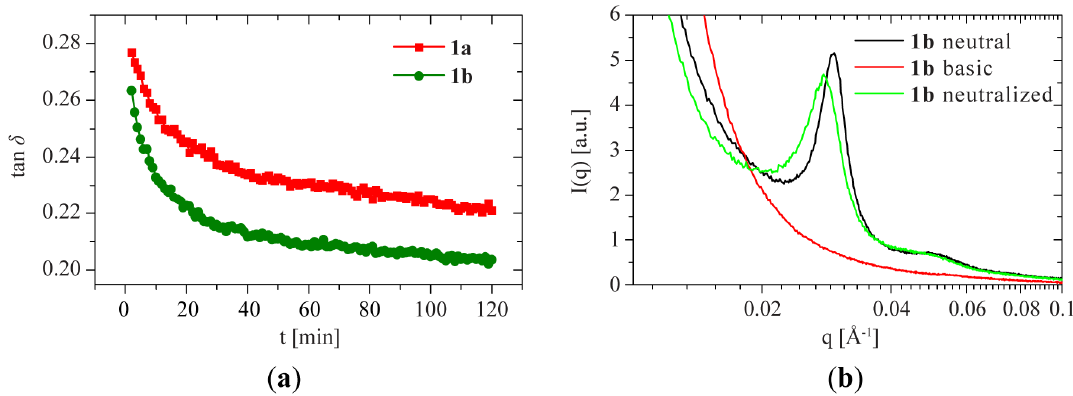
Figure 10. pH dependence of the mechanical properties and of the SAXS profile. ( a ) Gel curing followed by plotting tan δ , as a function of time for 1a (green squares) and 1b (red circles) at 10 wt %; ( b ) Small-angle X-ray scattering profiles of 1b at 10 wt % under neutral (black), basic (red) and neutralized (green)